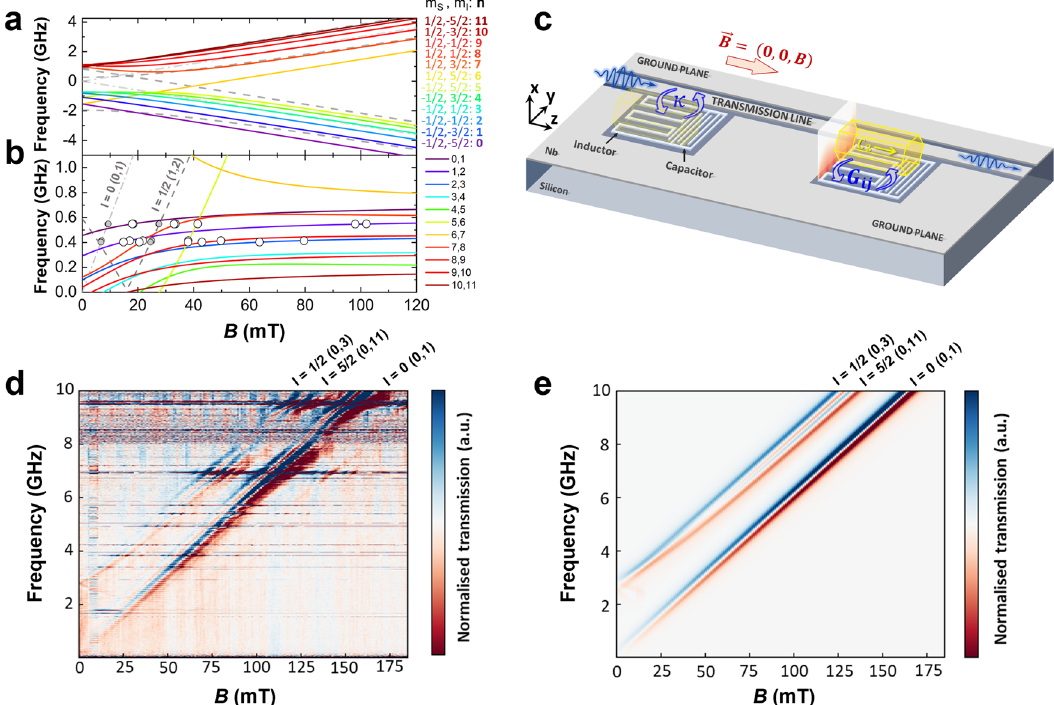
derivatives of [Yb(trensal)] molecules as a function of the magnetic fi eld B . Solid colored lines correspond to [ 173 Yb(trensal)] ( S = 1/2, I = 5/2),